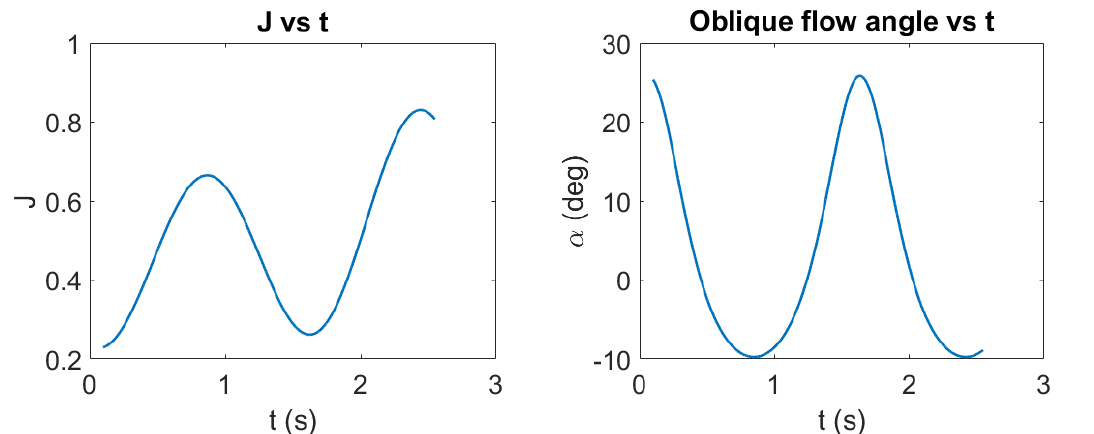
Figure 7. J and α as a function of time for the unsteady open water propeller test